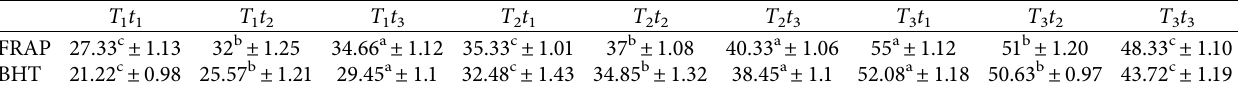
Table 4: Interaction efects of temperature ( T ) and time ( t ) on FRAP (mM Fe(II)).